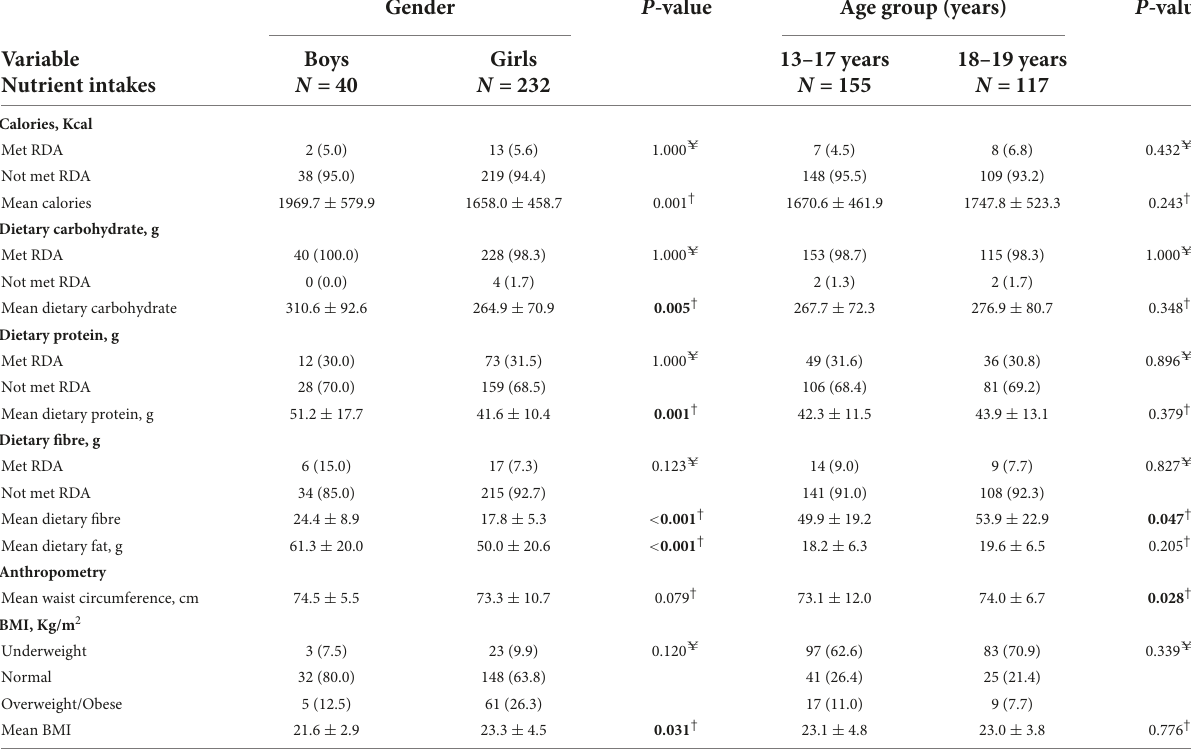
TABLE 1 Sociodemographic variables, calories and macronutrient intakes, and anthropometric variables. Gender P